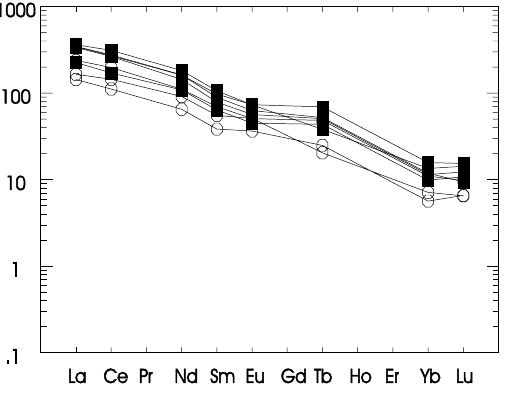
Fig. 5–REE-spectraofsamplesofqz-diorites,qz-monzodiorites and OPX-gabbros.